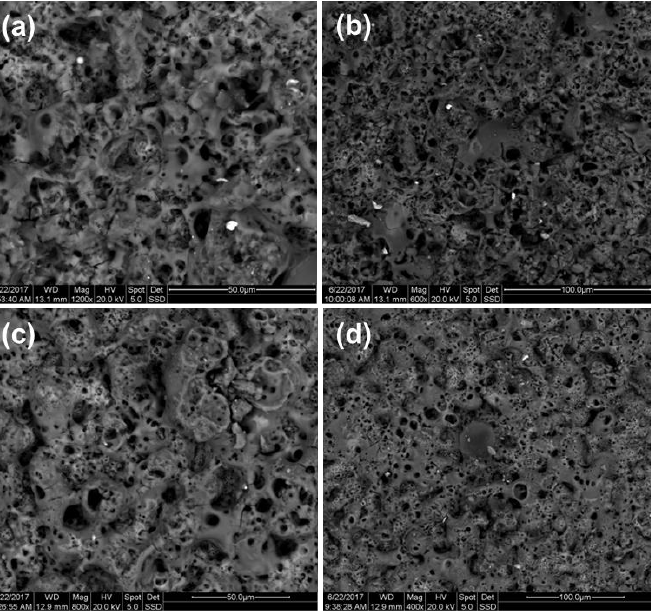
Figure 3. SEM images of prepared coating by micro-arc oxidation with different time: ( a , b ) MAO-1 and ( c , d ) MAO-2 coating.